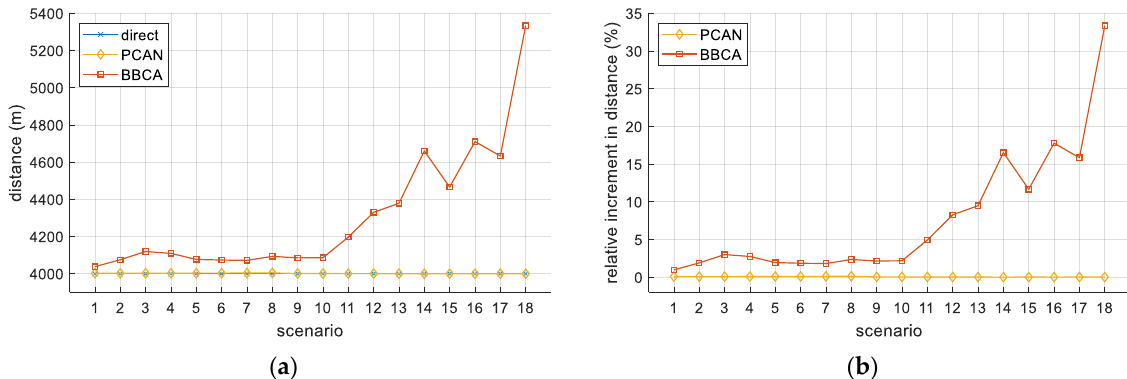
Figure 8. Two-UAV study. Distance traveled: ( a ) absolute values; ( b ) relative increase with respect to the direct algorithm.